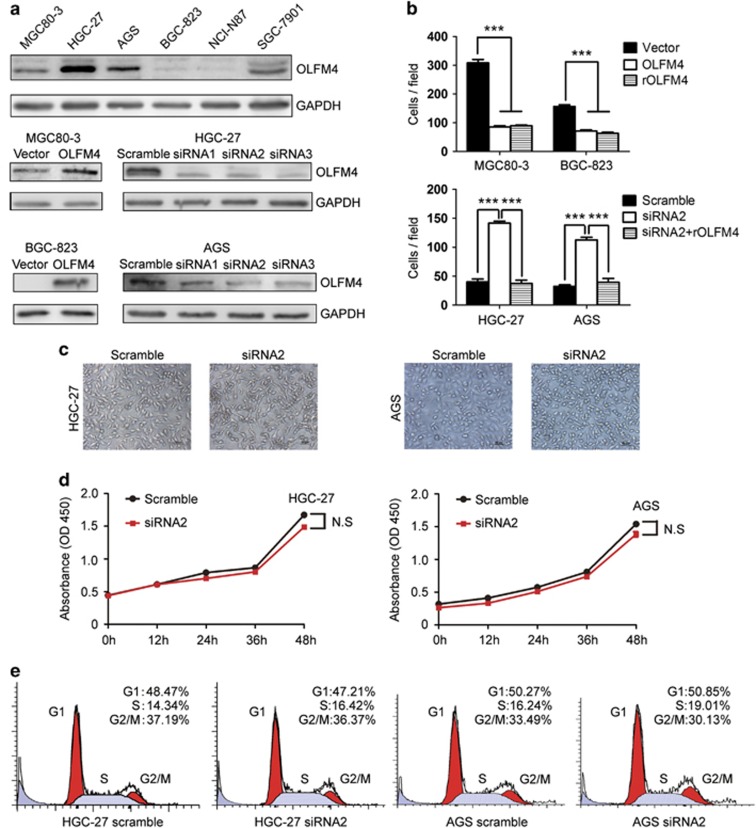
OLFM4 decreases the migration potential and induces morphologic change in gastric cancer cells. (a) The expression of OLFM4 in wild-type and transfected gastric cancer cells were detected by western blotting. (b) In the upper panel, the effects of OLFM4 overexpression or recombinant OLFM4 (100 ng/ml) on the migration of MGC80-3 and BGC-823 cells were examined. In the lower panel, the effects of OLFM4 siRNA with or without recombinant OLFM4 (100 ng/ml) on the migration of HGC-27 and AGS cells were examined with transwell assay. (c) The effect of OLFM4 depletion on morphologic change in gastric cancer cells. (d) The effects of OLFM4 siRNA on the viability of HGC-27 and AGS cells were examined with CCK-8 assay. (e) The effect of OLFM4 siRNA on the cell cycle of HGC-27 and AGS cells were detected by flow cytometry assay. In (b–e), experiments were repeated three times. In (b), error bars indicate means±s.e.m. In (c) and (e), images are representative of three independent experiments. N.S, not significant; ***P<0.001; rOLFM4, recombinant OLFM4.